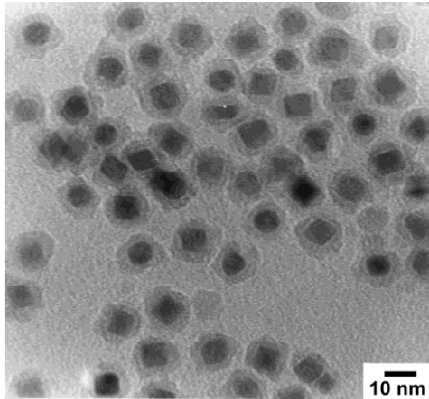
O particles. The polymer coatings are 2 3